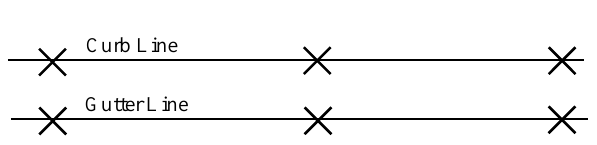
Figure 1. Observation method taken on Curb and Gutter Lines